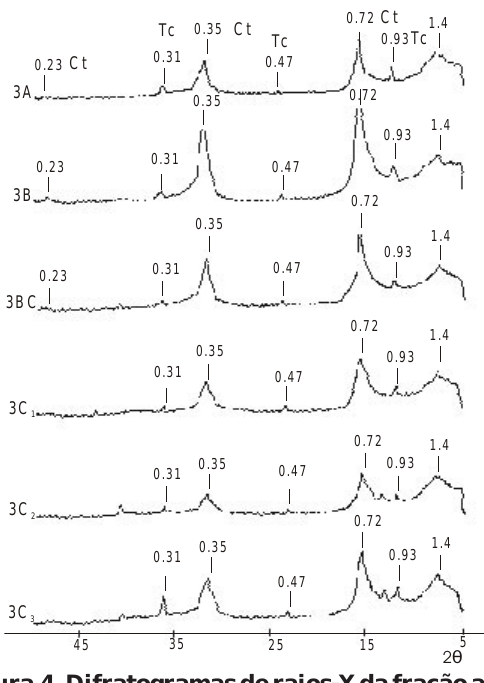
Figura 4. Difratogramas de raios-X da fração argila desferrificada para o perfil 3 – MTf (espaçamen- to d em nm) (Ct = caulinita, Tc = talco).